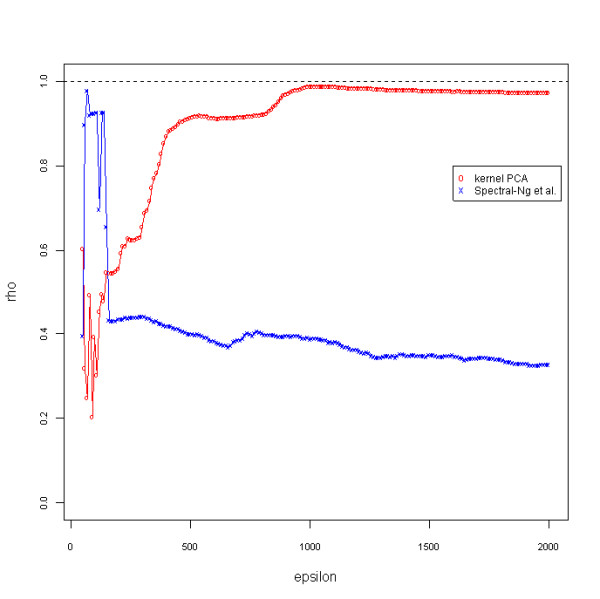
Parameter optimization plot for image example. Regression coefficients for image ordering determined by different epsilon values for kernel PCA and the spectral method from Ng et al. Epsilon values were increased to 300,000 to assess image ordering accuracy (data not shown), but truncated for the plot to better visualize the global maxima. The dashed black horizontal line indicates a rho statistic value of 1, though neither method reaches this threshold. Large fluctuations in the rho statistic are observed for both methods at minimal values of epsilon. For kernel PCA a non-optimal solution is determined in the variable region, while for the spectral method from Ng et al., a maximum is determined in this region. The variability in the rho values at these minimal values can be associated with the optimal convergence of remote and local distances in the weight matrices (Figure 6) of kernel PCA and the spectral method from Ng et al (L). Small values of the epsilon parameter provide minimal convergence of the L matrix distribution tails (very small distances and very large distance), which is optimal for the spectral method from Ng et al for this example. For kernel PCA, larger values of the epsilon parameter provide convergence of large distances and greater convergence of small distances in the Gaussian radial basis function kernel matrix, which is determined to be optimal for this example.